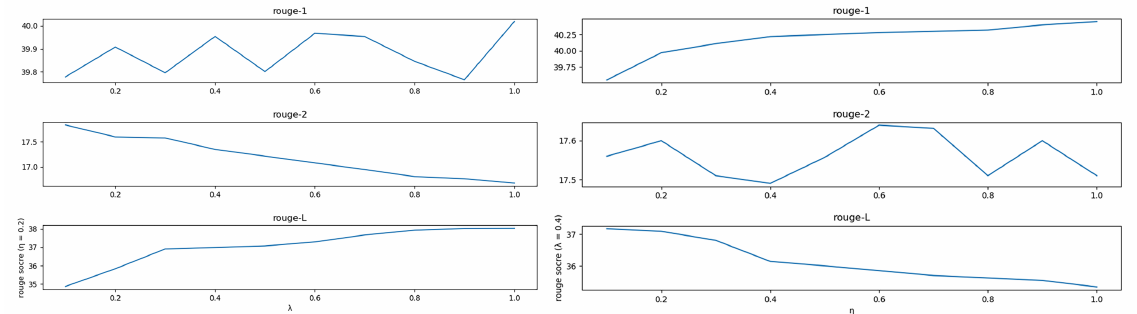
Figure 5. ROUGEscores achieved on the validation set with various value combinations of λ and η . The two parameters affected the result from different